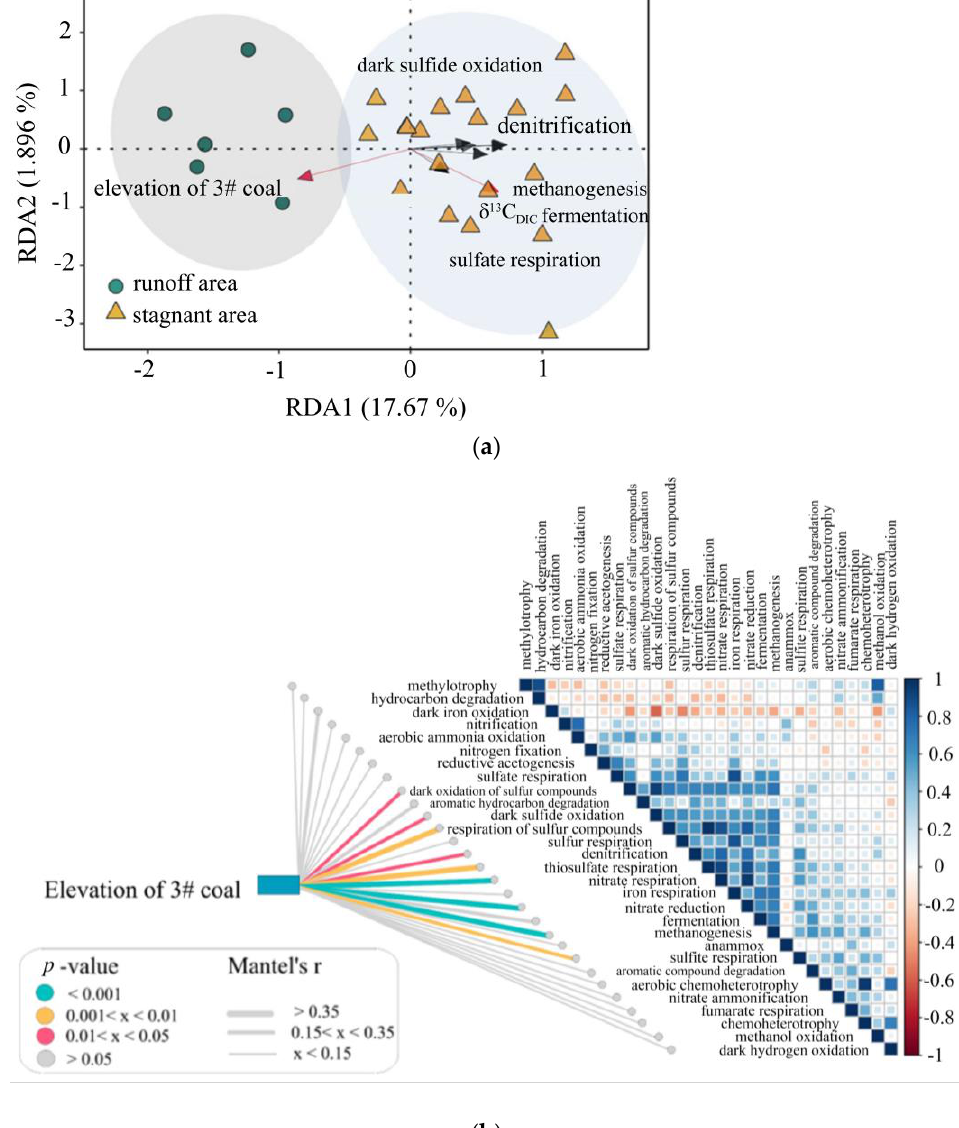
Figure 7. ( a ) Linkages between microbial community and environmental variables. RDA analysis displays microbial community (symbols, including C-N-S microorganisms such as fermentation bacteria, methanogens, sulfate-reducing bacteria, denitrifying bacteria and dark sulfide oxidation bacteria) and environmental variables (arrows, including elevation of #3 coal). The value of the axis is the variance percentage explained for the axis. ( b ) Pairwise comparisons of functional communi- ties are shown with a color gradient denoting Spearman’s correlation coefficient. Taxonomic and functional community structures were related to each environmental factor by Mantel tests. Edge width corresponds to the Mantel’s r statistic for the corresponding distance correlations, and edge color denotes the statistical significance. 5.4. Degradation Mechanism of Organic Matter and Biogenic Methane By classifying the flora in the study area according to the C-N-S function, the heatmap shows that the C-cycling microbial communities, including methanogenesis, fermenta- tion, and aromatic compound degradation communities, were enriched in the stagnant areas (Figures 8a,b and S13). The significant difference between stagnant areas and runoff areas was verified by Welch’s t- test (Figure 8c) ( p < 0.05, 95% confidence intervals).